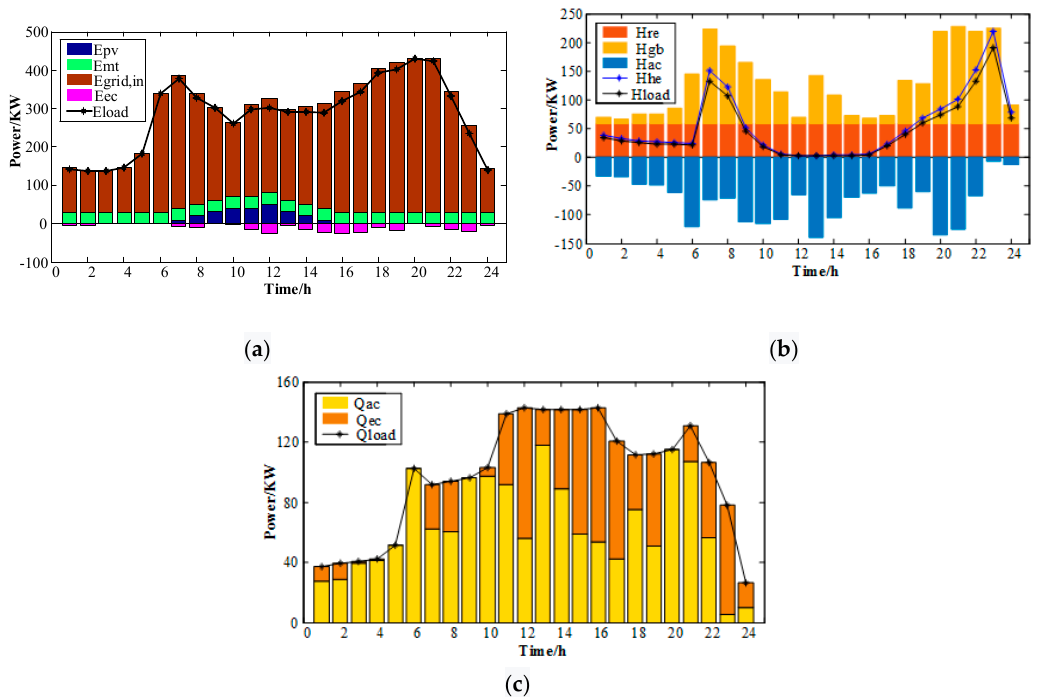
Figure 6. Power balance diagram under the FEL strategy: ( a ) Electric power balance; ( b ) Heat power balance; ( c ) Cold load balance.